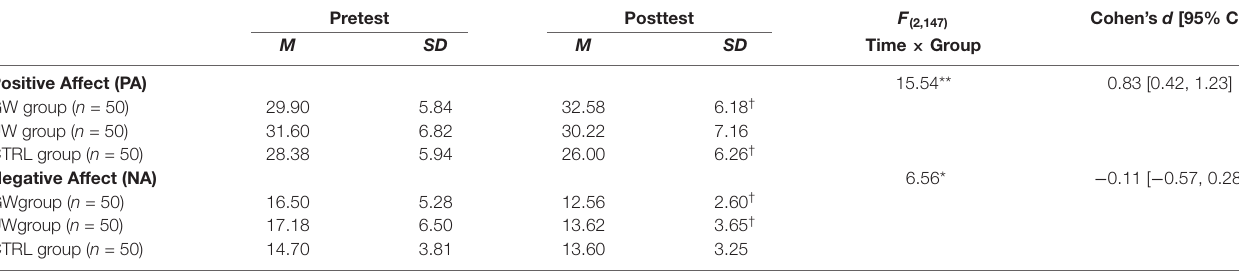
TABLE 1 | Descriptive statistics for positive and negative affect scores as a function of Group and Time, ANOVA results, and effect sizes of the differences between the two intervention groups (Green Exercise vs. Urban Exercise) on the change